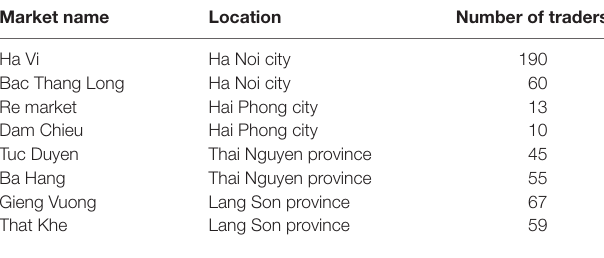
taBlE 1 | Number of traders in survey